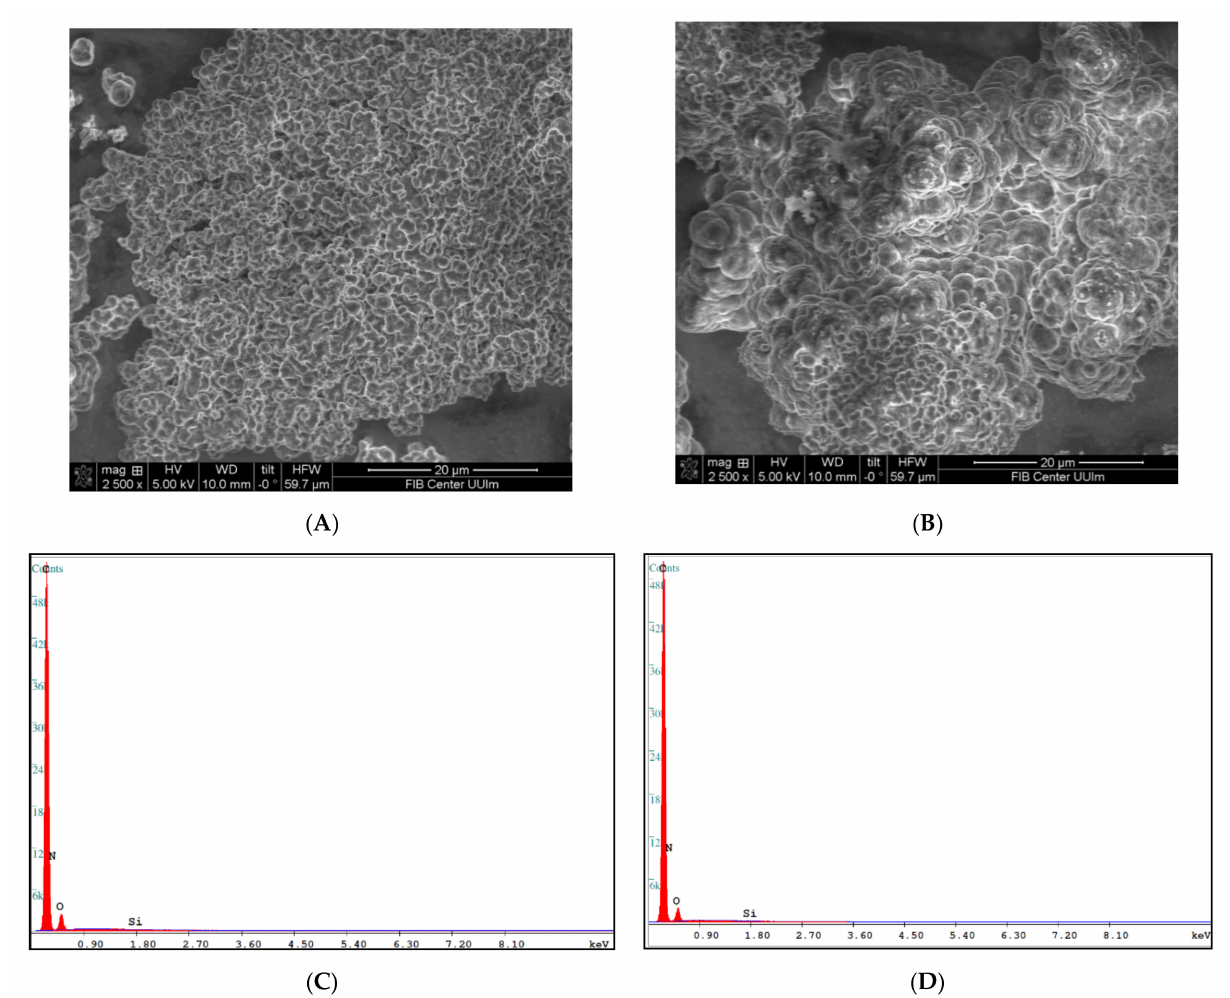
Figure 2. Scanning electronic microscopy (SEM) images for ( A ) MIP and ( B ) NIP and X-ray spectrometer (EDS) spectra for ( C ) MIP and ( D )